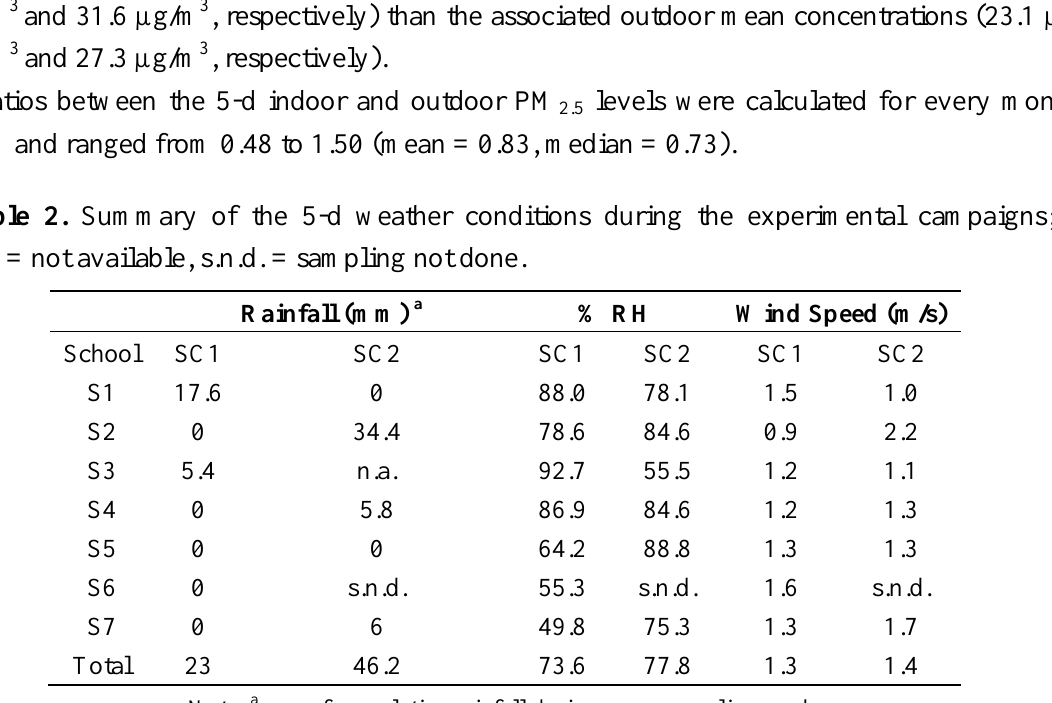
Figure 3. Linear regression between the 5-d gravimetrical outdoor PM (C ) and the corresponding indoor levels (C o monitoring